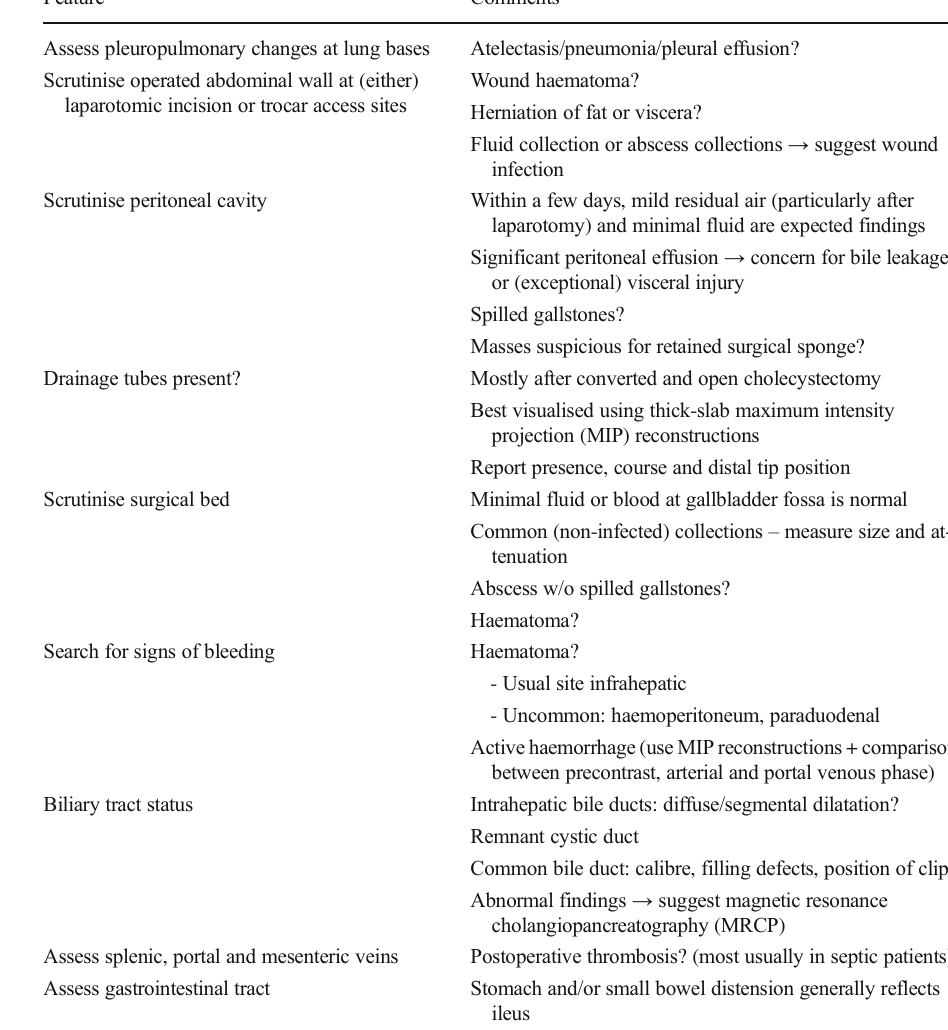
Table 2 Checklist for the interpretation of early computed tomography (CT) after laparo- scopic, converted and open cholecystectomy